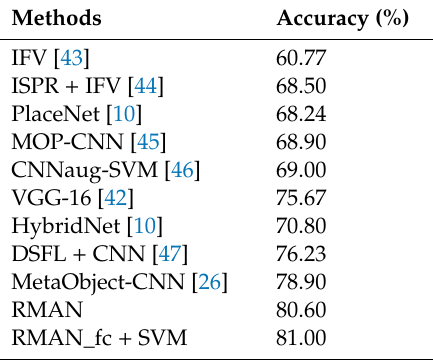
Figure 7. Classification accuracy with a di ff erent number of iterations on the Scene 30 dataset. Table 2. Comparison of Recurrent Memorized Attention Network (RMAN) with other methods on MIT Indoor